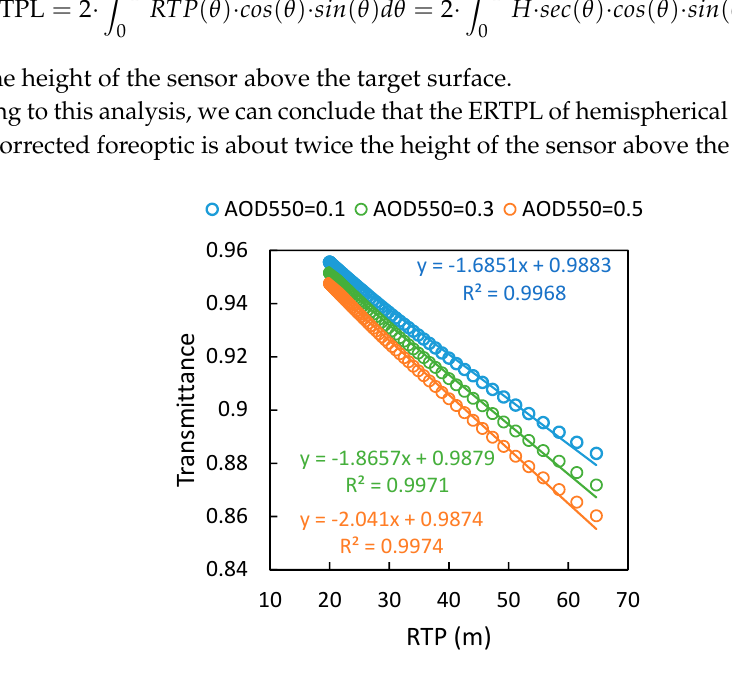
Figure 3. Variation of the transmittance of up-welling radiation at 761.1 nm with the RTPL according to simulations made by MODTRAN 5. The AOD 550 is set as 0.1, 0.3, and 0.5; the sensor height is 20 m and the range of the view zenith angle is 0–72 ◦ ; the other parameters are set as given in Table